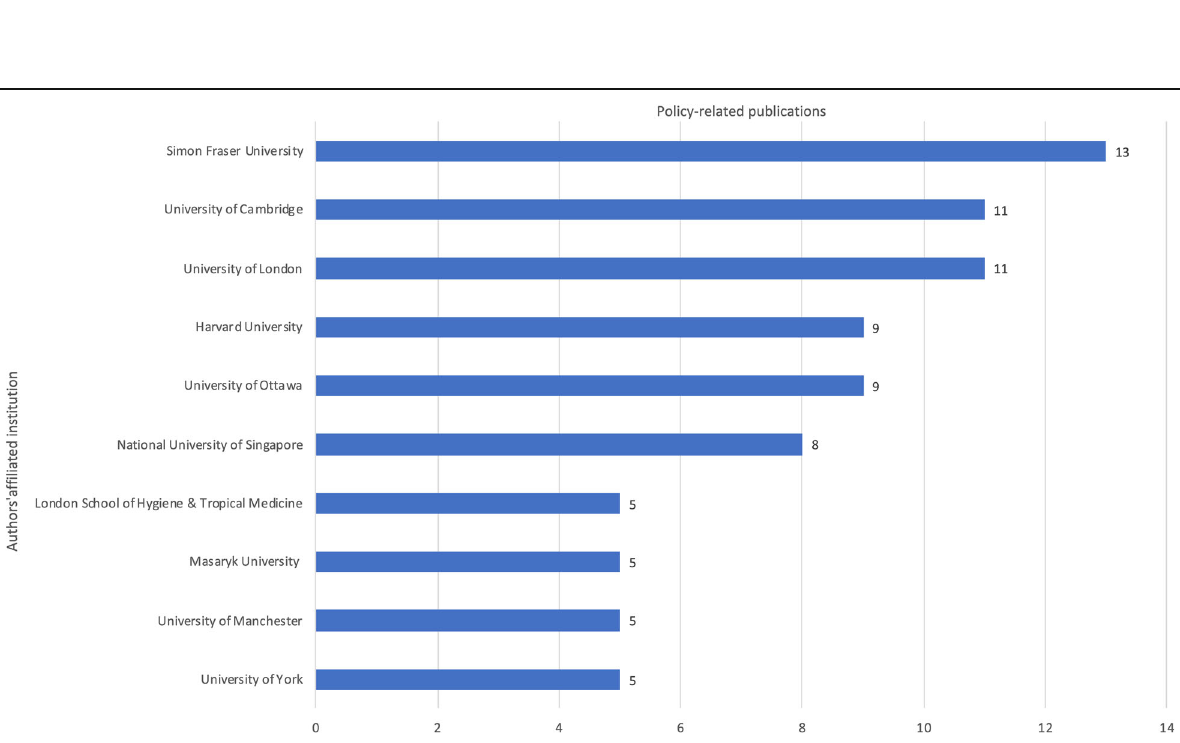
Fig. 5 Institutional affiliations of authors producing most policy-related publications on medical